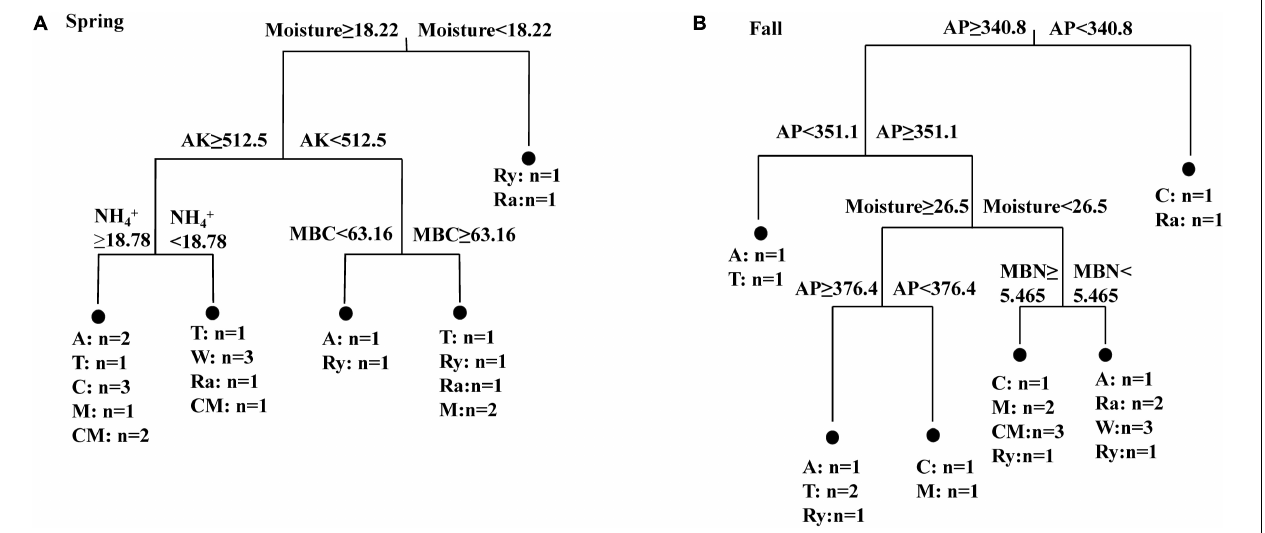
FIGURE 3 | Multivariate regression tree analysis of alpha diversity (OTUs, Chao 1, Shannon and Simpson indices) of diazotrophs and soil physicochemical properties in the (A) Spring and (B) Fall cropping seasons. Treatments and the number of samples included in the analysis are shown at the bottom. AK, available potassium; AP, available phosphorus; MBC, microbial biomass carbon; MBN, microbial biomass nitrogen.